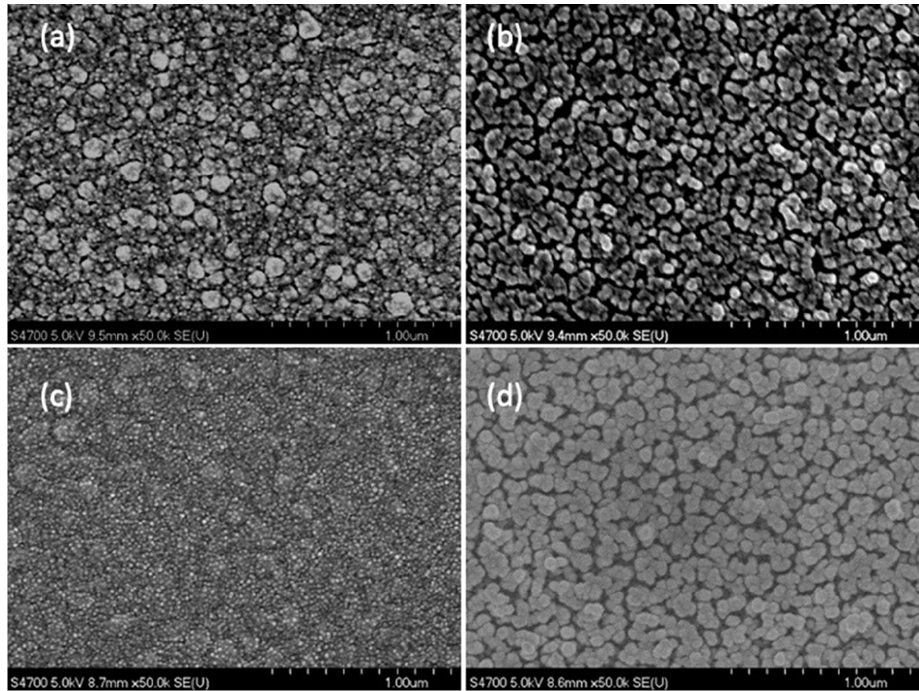
Figure 2. Planar view FE-SEM micrographs of HKUST-1 SURMOF thin films grown on borosilicate glass substrates displaying the differences in MOF morphology between undoped pristine MOFs versus TCNQ-doped MOFs of very loosely stacked MOF grains with very noticeable gaps between individual MOF grains, which are especially pronounced following TCNQ loading of thicker 40 deposition cycles of MOF films: ( a ) 10 cycles pristine MOF; ( b ) 10 cycles TCNQ; ( c ) 40 cycles MOF pristine; and ( d ) 40 cycles MOF with TCNQ-loaded MOF (adapted from [33]).